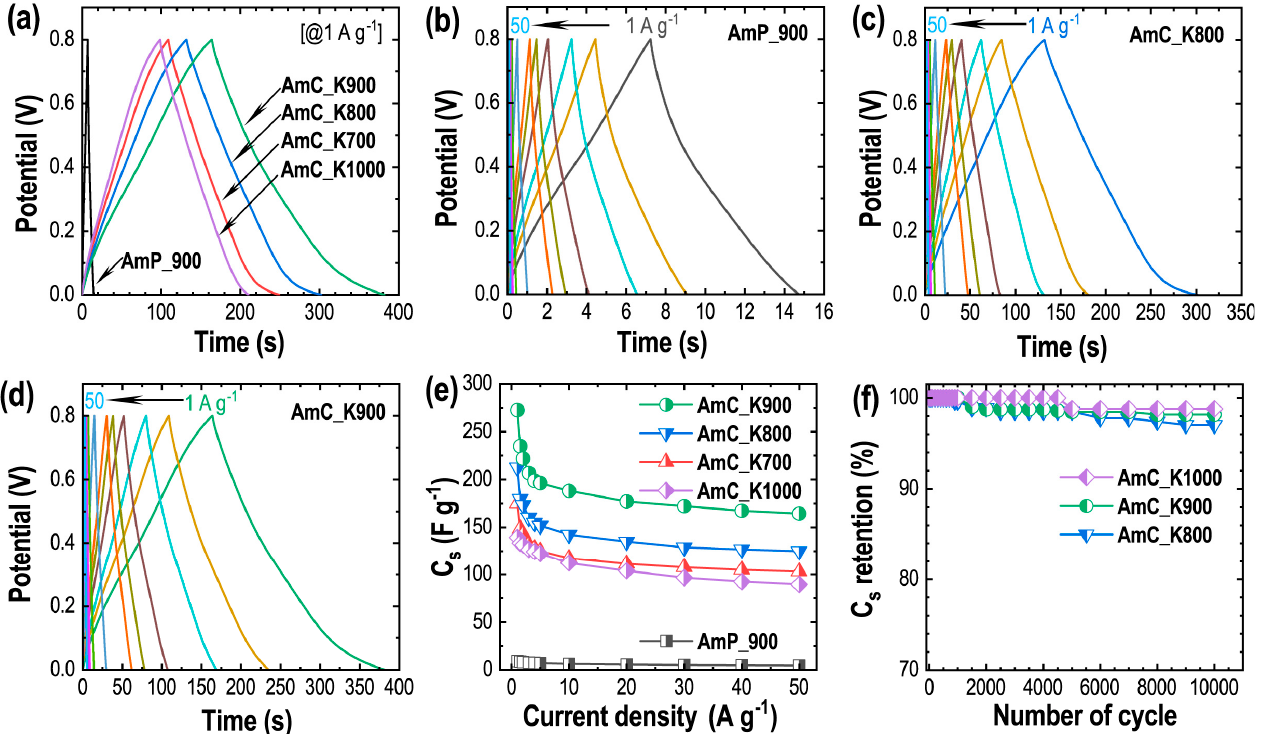
Figure 7. GCD measurement results: ( a ) Comparison of GCD profiles of all the electrodes recorded at 1 A g − 1 ; GCD curves recorded at various current densities (1, 1.5, 2, 3, 4, 5, 10, 20, 30, 40, and 50 A g − 1 ) for ( b ) AmP_900; ( c ) AmC_K700; ( d ) AmC_K800; ( e ) AmC_K900; ( f ) AmC_K1000.